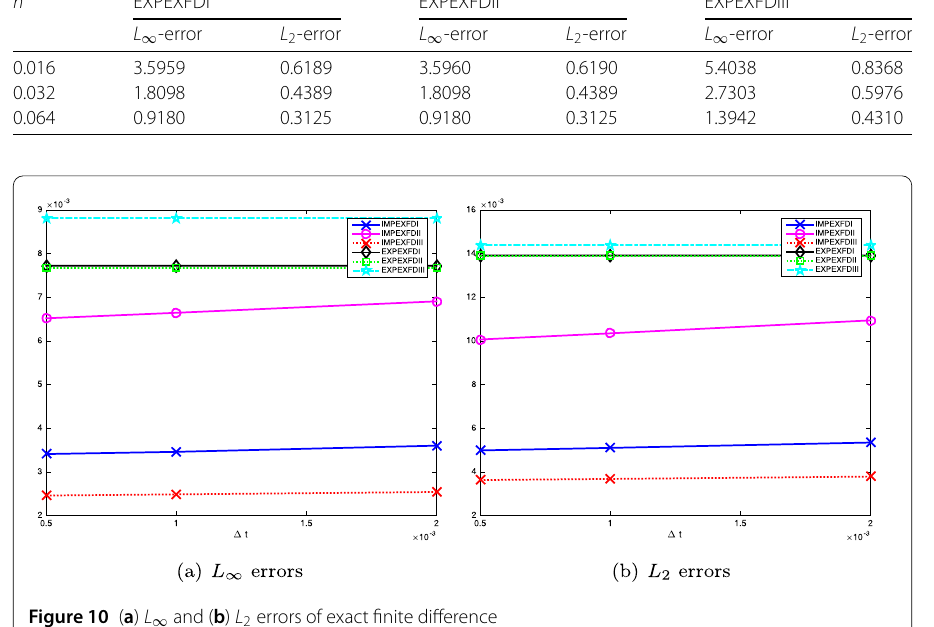
exact solution and the NSFD scheme for small step sizes. Absolute errors, L ∞ and L 2